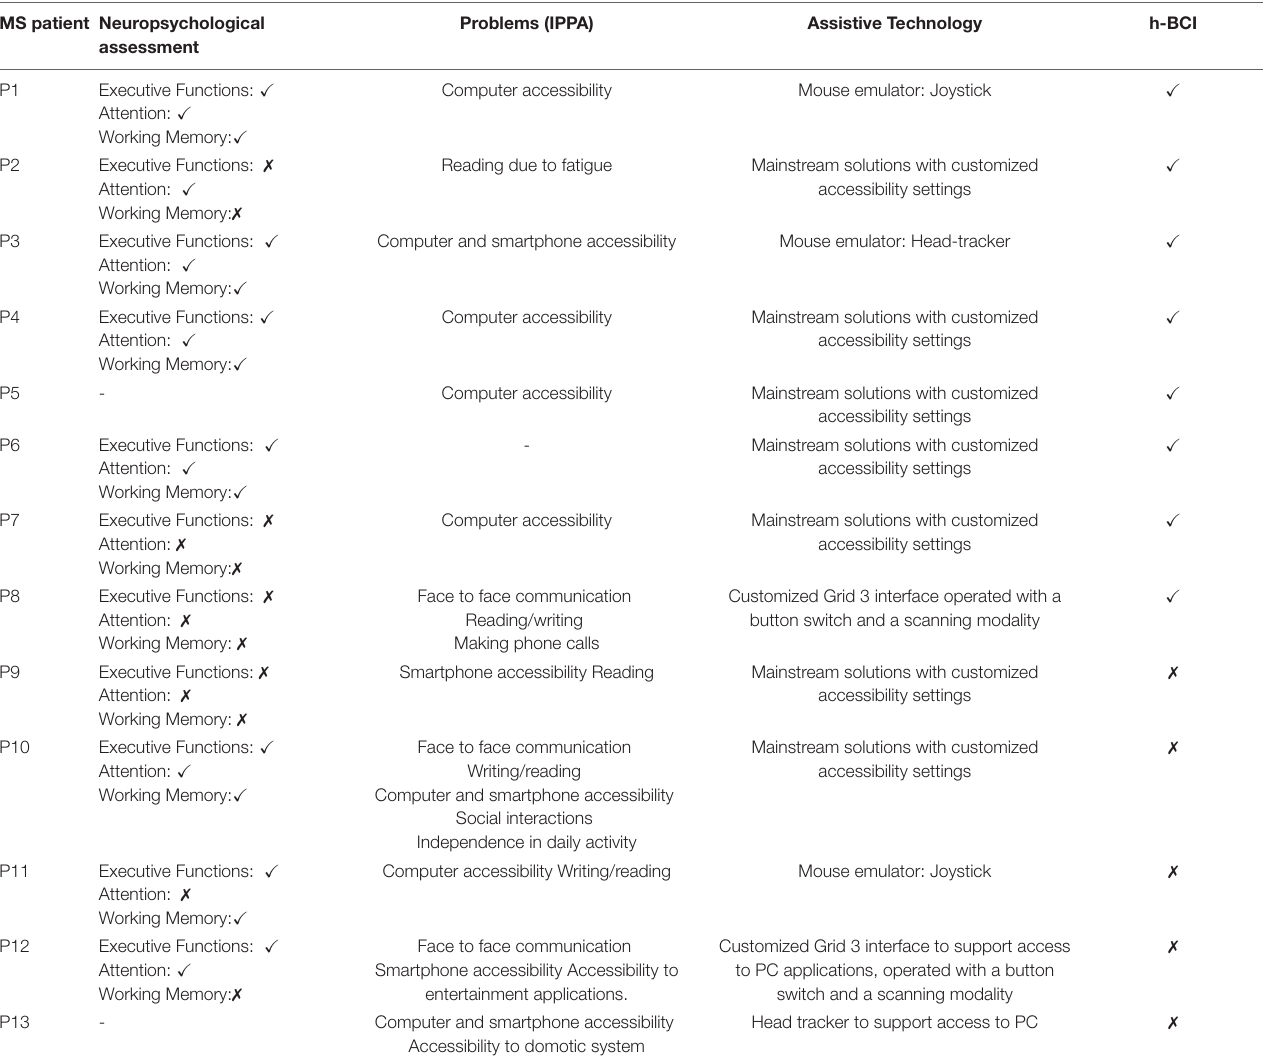
TABLE 1 | Information about the neuropsychological assessment, the problems, the assistive technology, and the participation in the h-BCI evaluation for each patient included in the study. MS patient Neuropsychological assessment